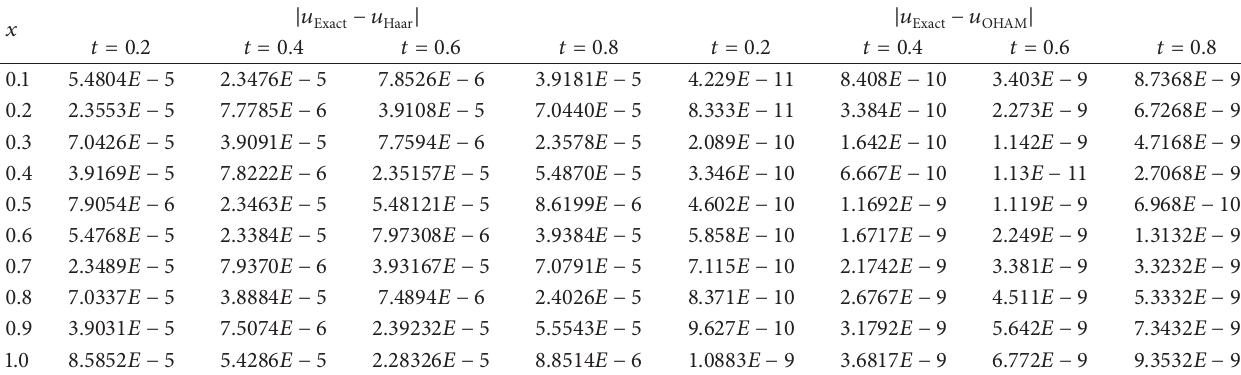
Table 1: The absolute errors in the solution of fractional order Burgers-Fisher equation (35) using Haar wavelet method and three terms for second-order OHAM with convergence control parameters 𝐶 1 = 0 and 𝐶 2 = −0.99999 at various points of 𝑥 and 𝑡 for 𝛼 = 1 .